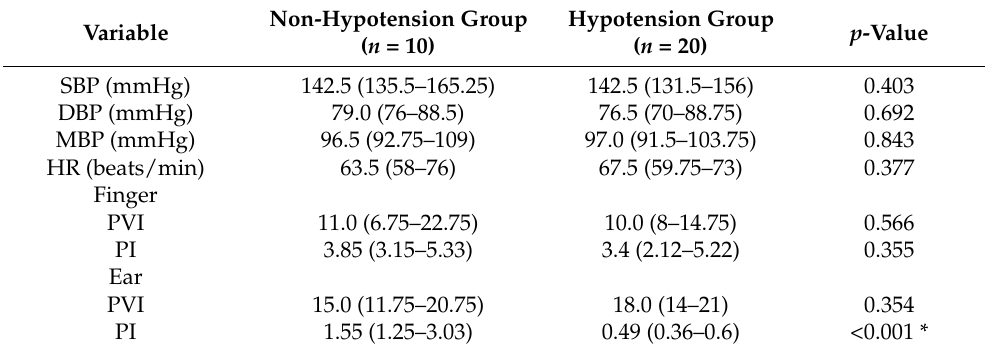
Table 2. Comparison of baseline hemodynamic data between patients with and without hypotension after the induction of anesthesia.